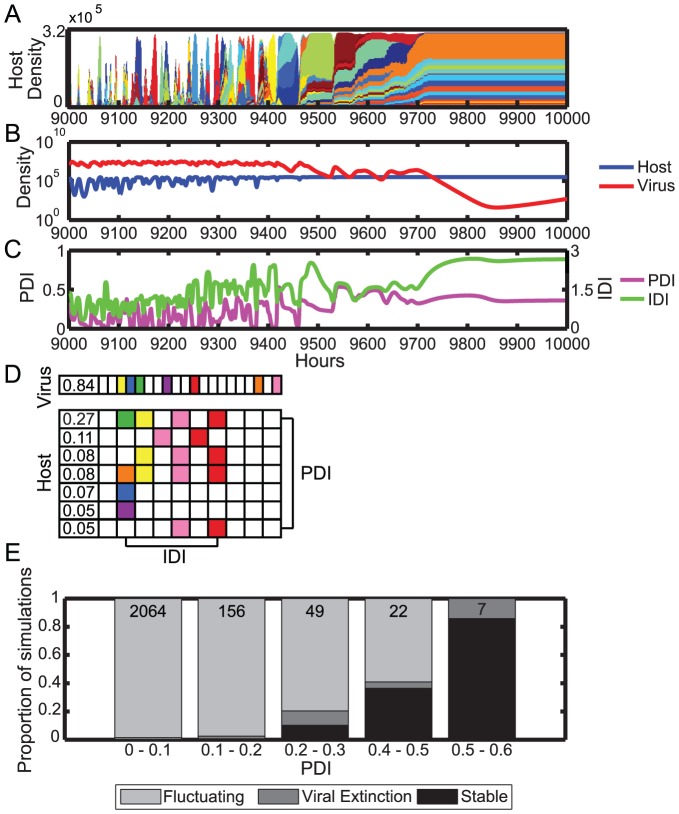
Host stability in a high DI population.(A) Plot of host dynamics for a representative model simulation containing an extended period of host population stability. Each color represents a host strain with a unique spacer set and color height is equal to population proportion of the strain; colors repeat when not touching. (B) Total population density in log-scale of host (blue) and virus (red) strains. (C) PDI (magenta, left y-axis) and IDI (green, right y-axis) metrics. (D) Spacer-protospacer matches at 9800 hours. The spacer and protospacer composition of each host or viral strain, respectively, is listed horizontally. The number in the first column indicates the proportion of each strain in the population, while the remaining boxes represent the spacer or protospacer state. Strains making up less than 5% of the population are omitted for clarity. (E) Numbers at the top of each bar designate the total number of simulations in each bin. A simulation is denoted as “stable” when the host population remains above 3e5 (close to carrying capacity) for at least 100 consecutive hours, and as “viral extinction” if the simulation ends prior to the designated endpoint due to reaching a viral population size below our density cutoff of 0.1/mL. Comparisons of subsampled data for stable and viral extinction show significant differences between means of all PDI bins (except between 0–0.1 and 0.1–0.2 stable simulations) and all IDI bins (except between1.8–2.4 and 2.4–3.0 stable simulations).